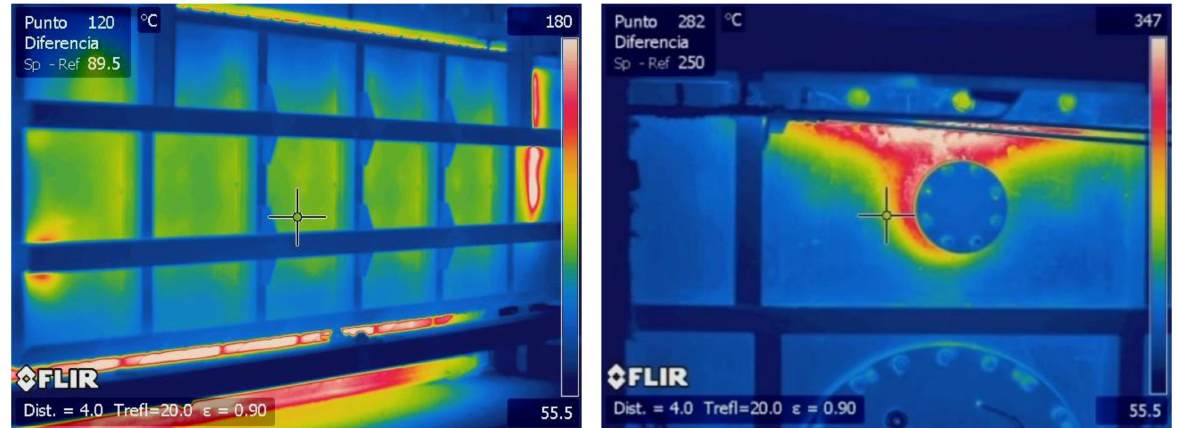
Figure 4. Samples of thermographic images used for boundary